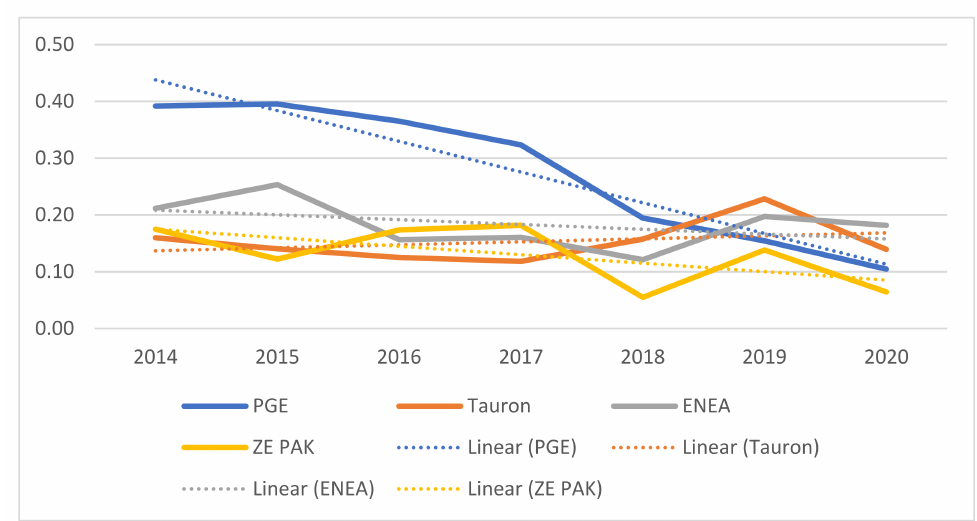
Figure 3. EBITDA ratios of the segments under review (Own